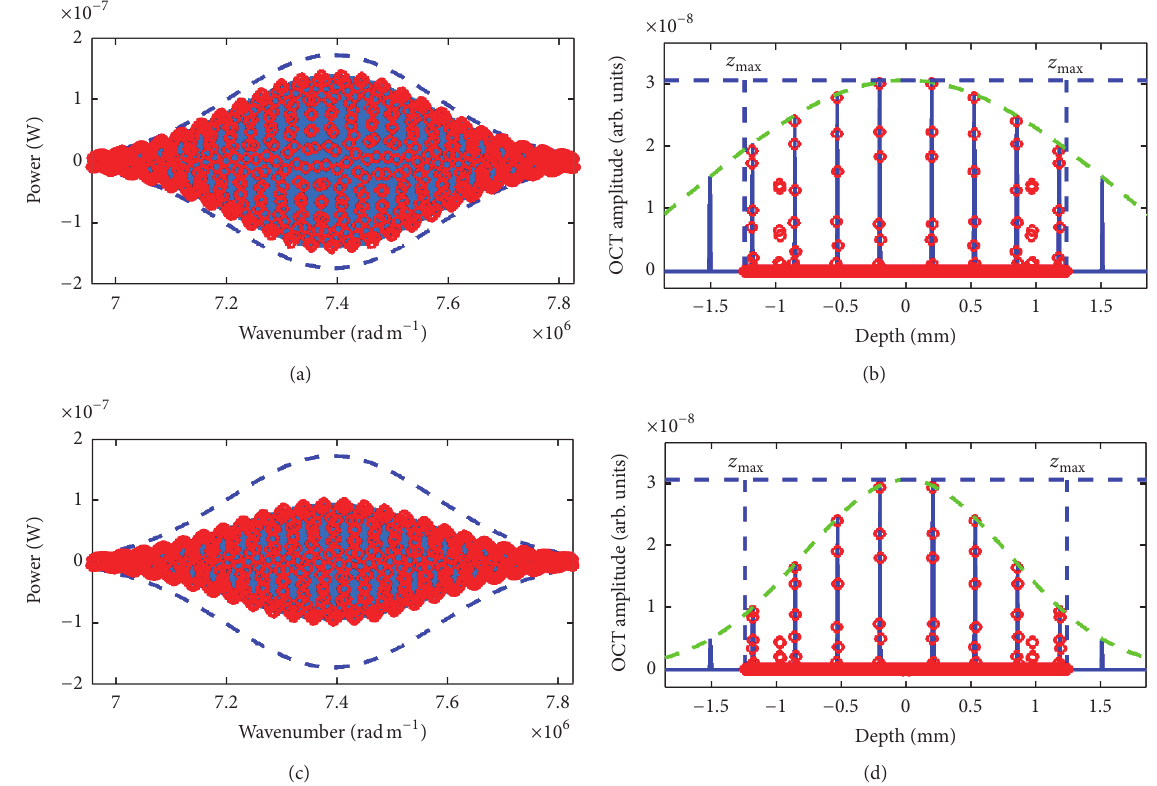
Figure 2: The effect of sampling and detection on the OCT signal. (a) For pixel integration the fringe contrast in the 𝑘 -domain is reduced relative to the input spectrum (blue dashed line) after convolution in the 𝑘 -domain in the continuous (blue continuous line) and sampled signal (red circles). (b) Due to pixel integration the signal in the 𝑧 -domain decreases in depth for the continuous (blue continuous line) and sampled (red circles) signal. The green curve indicates the OCT signal roll-off of (17). (c) Similar to (a) but for the effect of spectral integration with a resolution of 𝜎 𝑟 = 4𝛿𝑘 . (d) Similar to (b) but for the effect of spectral integration.